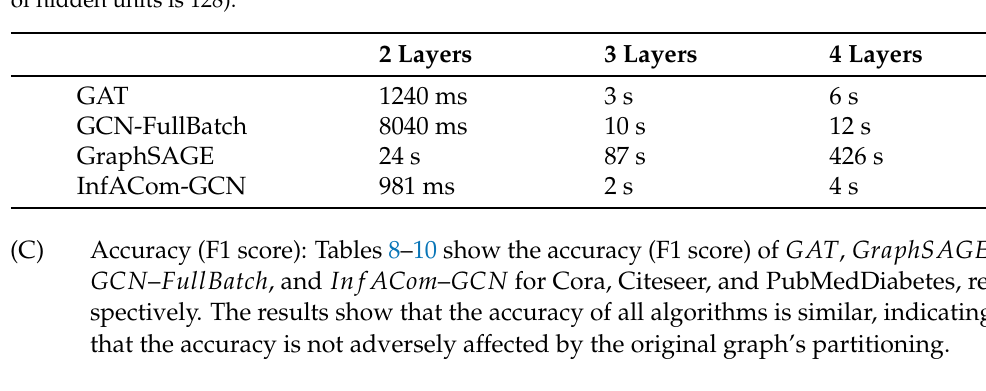
Table 8. Average accuracy of 50 epochs for Cora dataset using 2, 3, and 4 layers (the number of hidden units is 128).